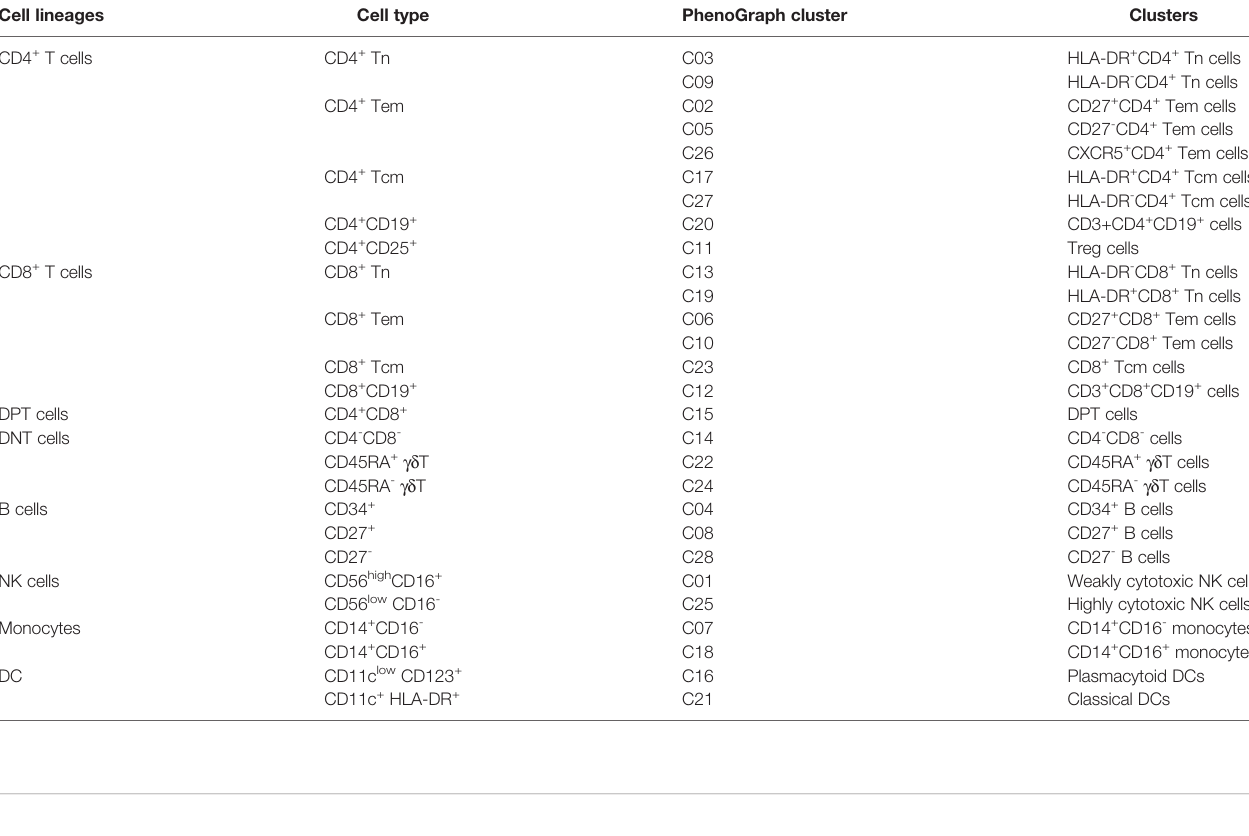
TABLE 2 | Comparison of PhenoGraph clusters with manually gated cell phenotypes.